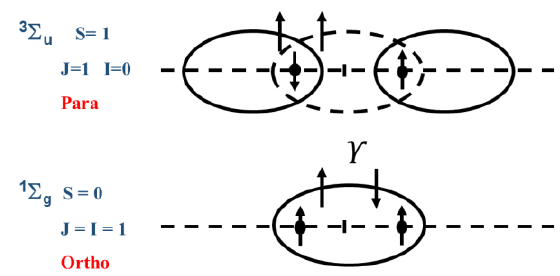
Fig. 5. The simultaneous “ flip-flop ” transition of the nuclear and electron spins that mixes the ground singlet and the excited